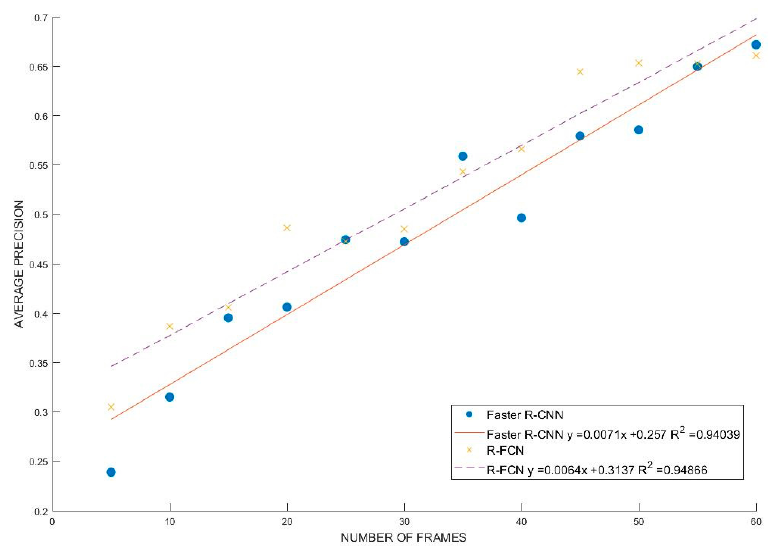
Figure 5. Average precision values for the Faster R-CNN and R-FCN models trained on 5–60 frames depending on the number of frames. With a determined trend line and calculated coefficient of determination R 2 .